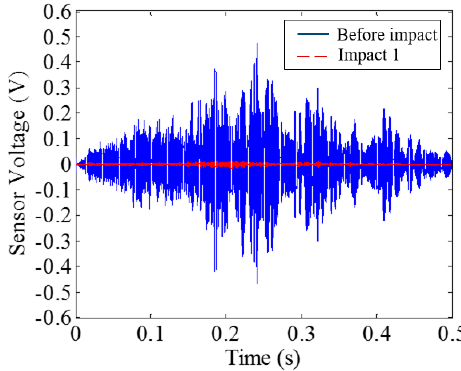
Figure 26 . Time-domain signal received by SA sensor in Mortar-2.